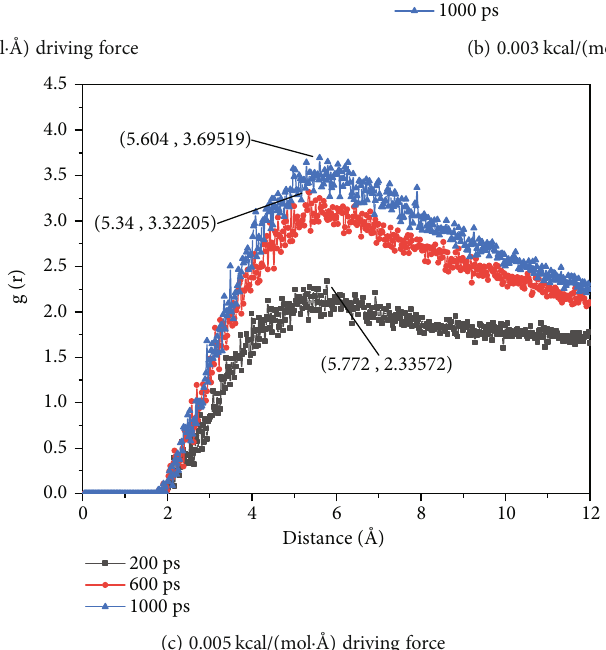
Figure 9: RDF at di ff erent driving forces and simulation